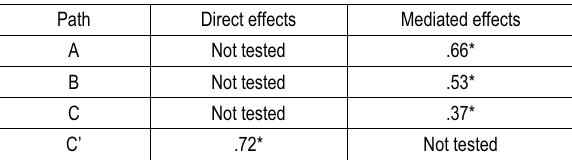
Table 5. Mediation analysis results: